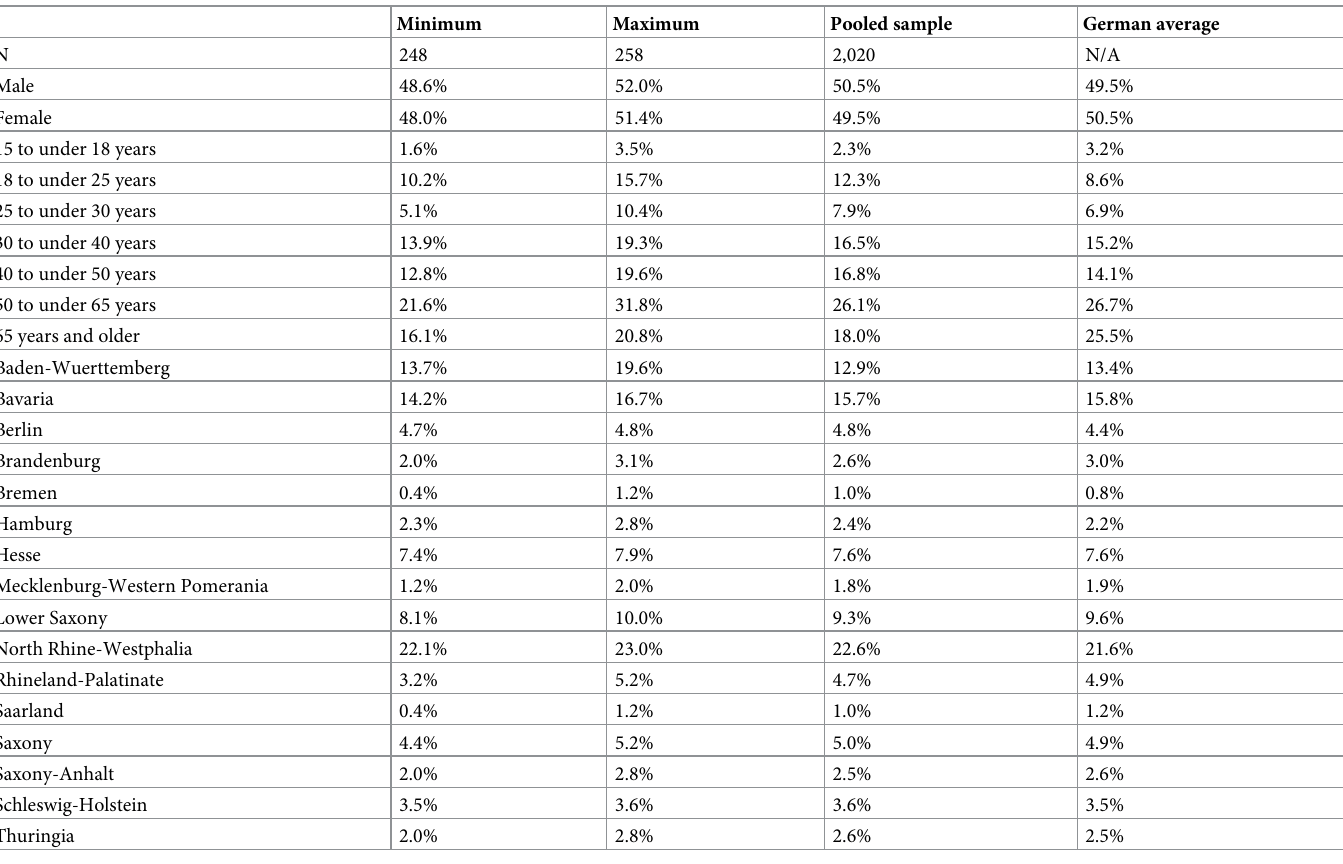
Table 1. Minimum and maximum values for respondents’ sex, age, and federal state in the eight questionnaires compared with the German average